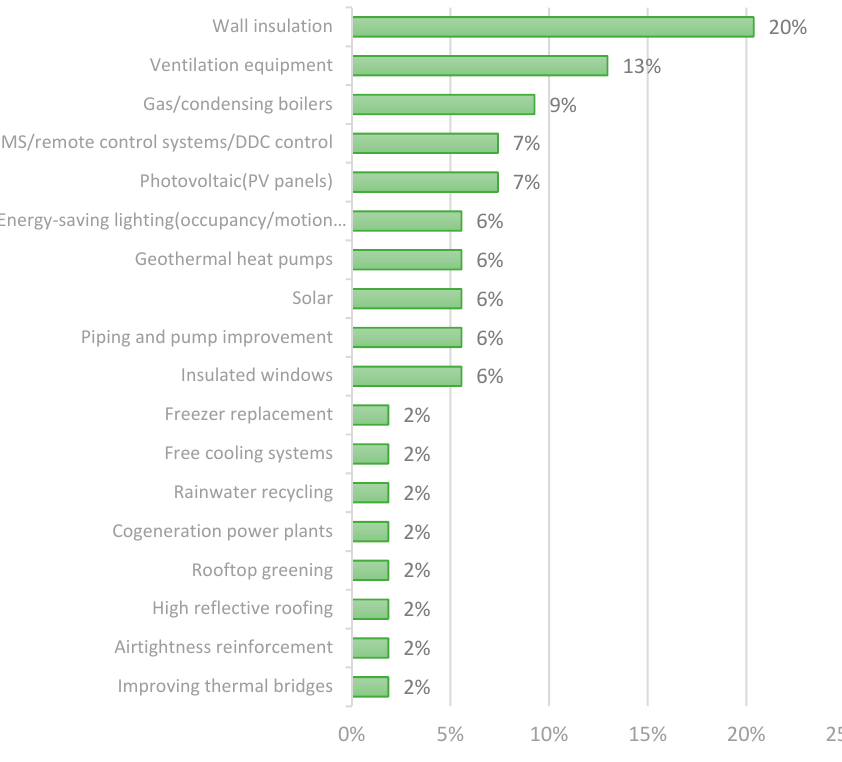
Figure 3. Visualization of the percentages of the applied technologies for green remodeling in urban regeneration projects in Europe and the United States.